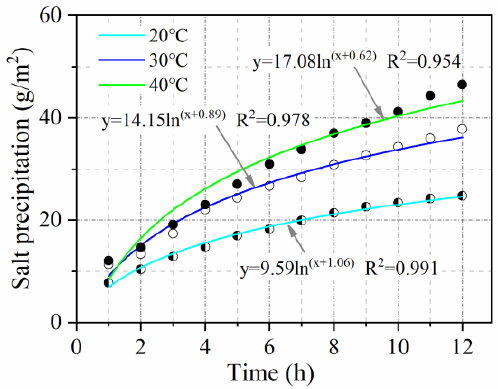
Figure 14. Effect of temperature on salt precipitation.